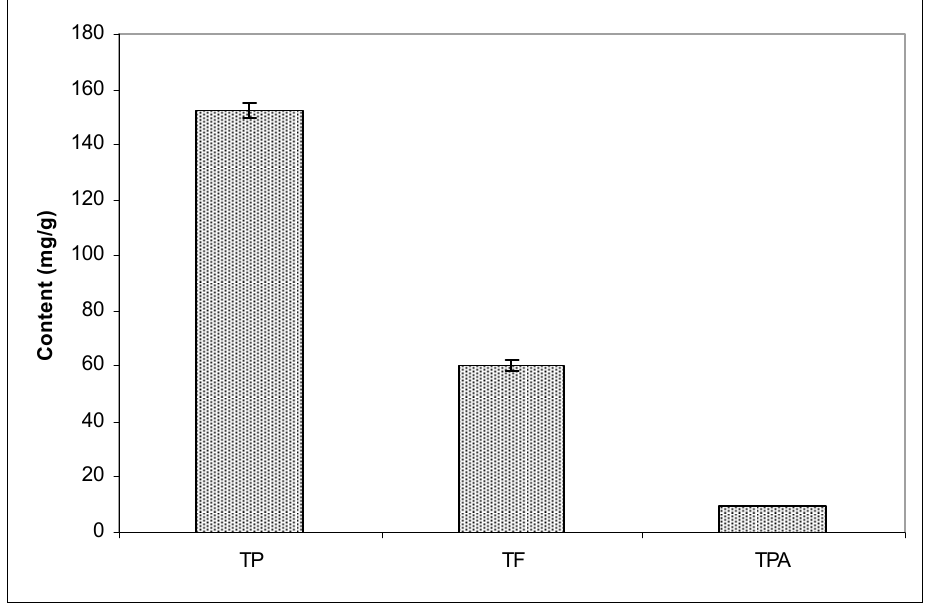
Figure 1. Content of total phenols (TP), total flavonoids (TF), and total phenolic acids (TPA) in ethanol extract of propolis.